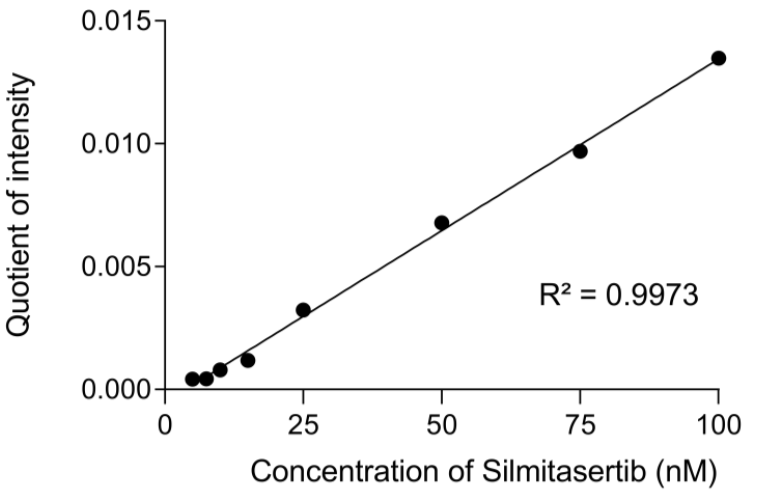
Figure 2. Exemplary calibration curve of silmitasertib for the concentration range 5 nM–100 nM. The values determined for the individual concentrations represent quotients of the area of the quantifiers m / z 223.1 (silmitasertib) and m / z 250.1 (internal standard).